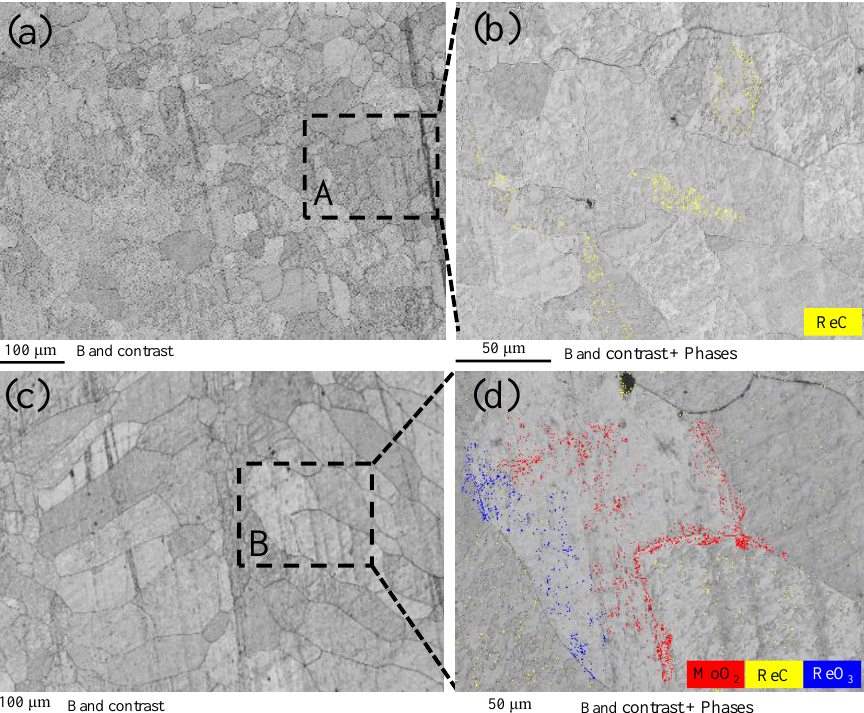
Figure 14. EBSD results in the BM and FZ of the Mo – Re alloy: ( a ) the band-contrast image of the BM; ( b ) the phase-distribution image of the A zone in the BM; ( c ) the band-contrast image of the FZ; ( d ) the phase-distribution image of the B zone in the FZ.